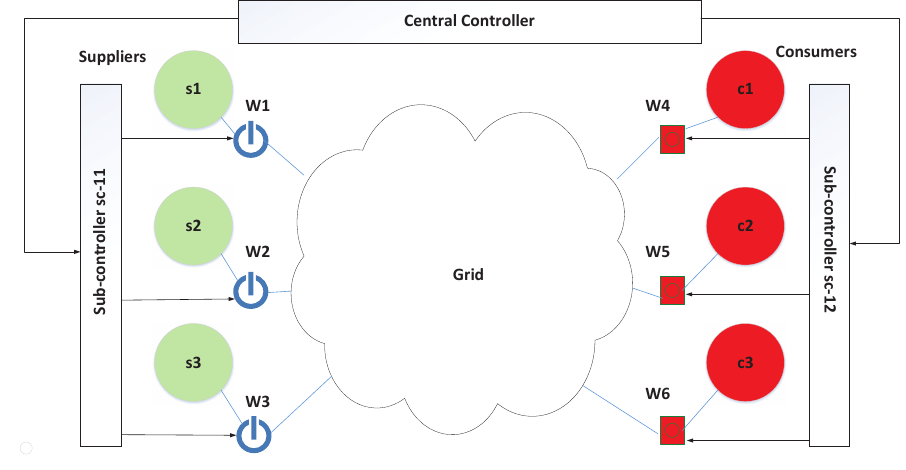
Figure 9. The model of energy trading system in the smart grid. Table 2. Description of data in the energy trading